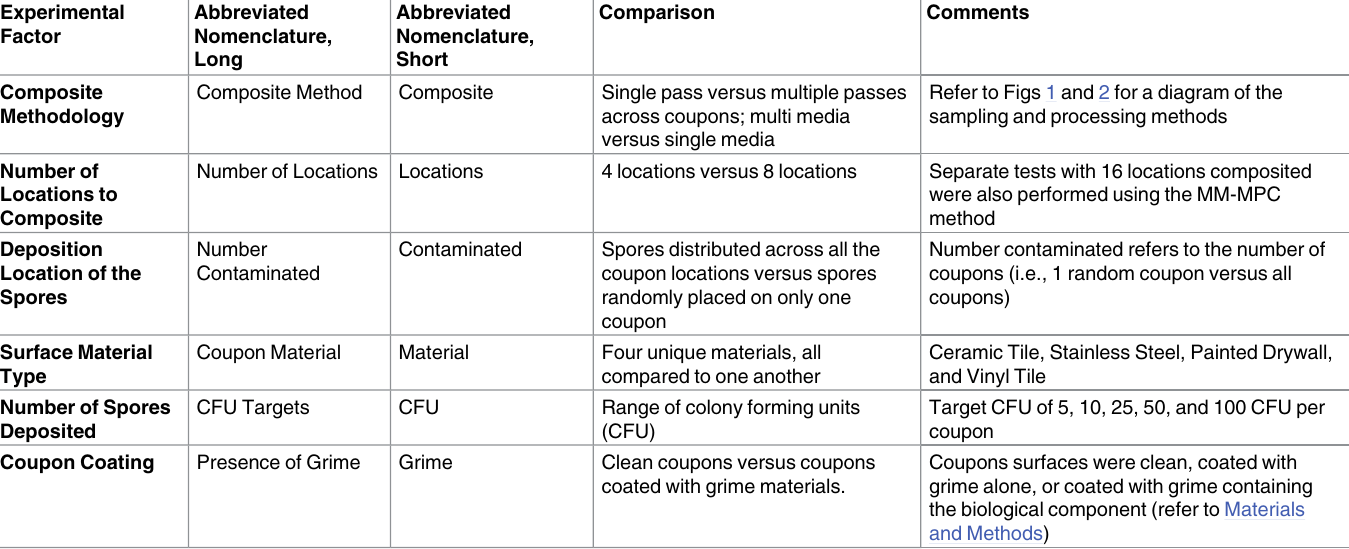
Table 1. The six experimental factors used in the study to evaluate